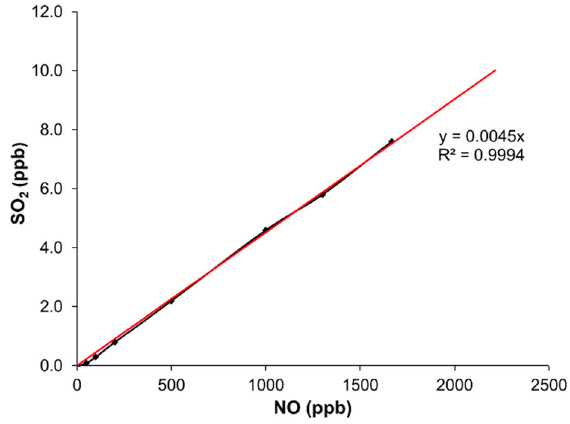
Figure 3. Sensitivity to NO of the Thermo 43i TLE sensor used in this study.